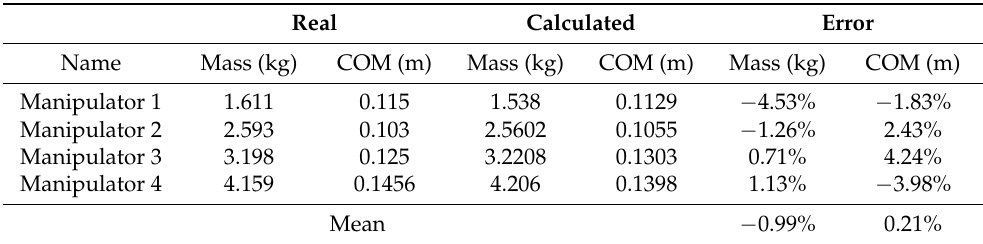
Table 2. Results of the identification of manipulators.